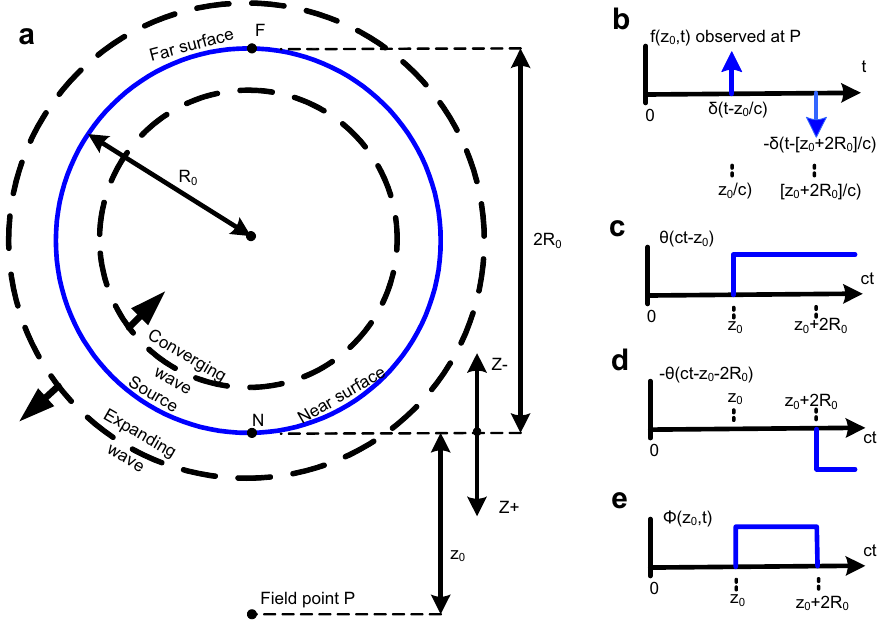
Figure 6. Radiated wave fronts and individual terms in the equations. The factor R 0 / [2[ R 0 + z 0 ]] is not included in the figures’ annotations. ( a ) A spherical source of radius R 0 with expanding and converging wave fronts. The distance z 0 is from the surface of the spherical source to the field point P at which the wave fronts will be observed. The two points N and F are the nearest and furthest points from P on the near and far surfaces of the spherical source. ( b ) Shows the impulses from the equation for the wave front f ( z 0 , t ): the impulse δ ( t − z 0 /c ) observed at P , at distance z 0 , is caused by an expanding impulsive spherical wave. This is the forward wave front for the spherical source from its near surface. The impulse − δ ( t − [ z 0 + 2 R 0 ] /c ) is caused by an impulsive spherical wave front, observed at P , that had initially converged with decreasing radius inward toward the spherical source’s center, passed through the center while changing sign, and then expanded with increasing radius toward P . This is the backward wave front for the spherical source from the far surface. ( c ) The wave field corresponding to the forward wave front. ( d ) The wave field corresponding to the backward wave front. ( e ) The combined wave field resulting from the summation of the forward and backward wave